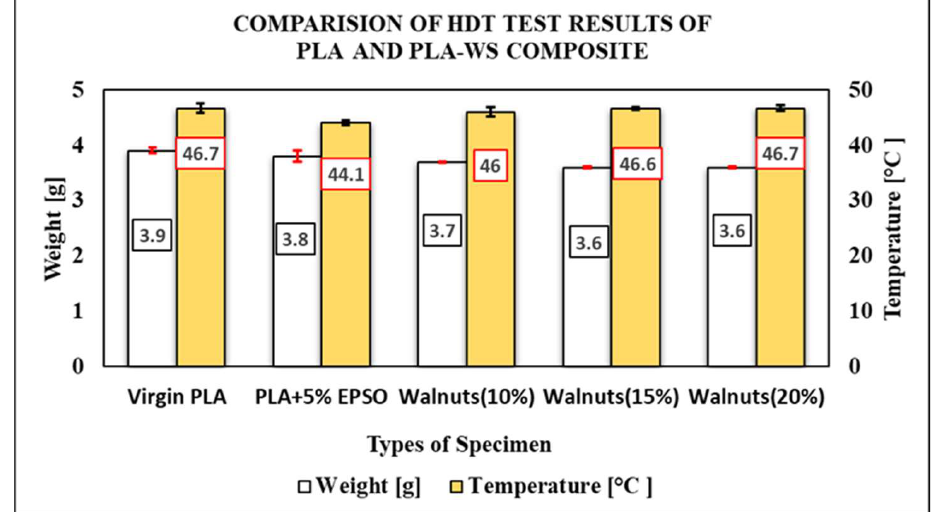
Figure 13. Comparison of HDT test results of PLA and PLA–WS composite.